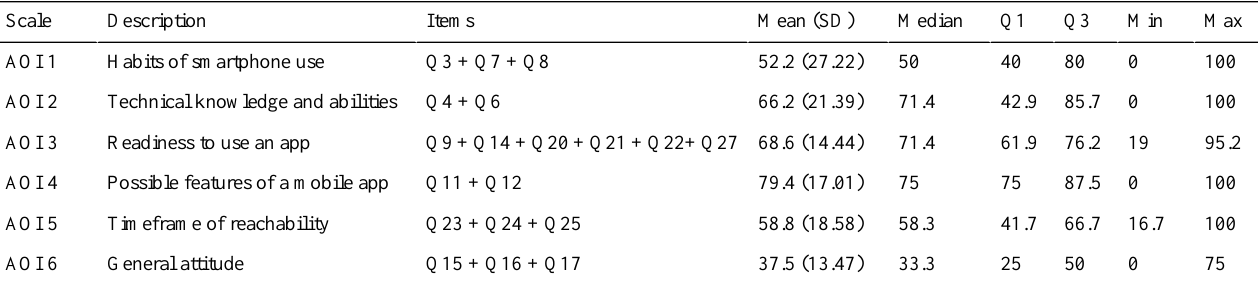
Table 2. Scores for the areas of interest (AOI) as calculated from the analysis of all returned questionnaires filled out at T0.